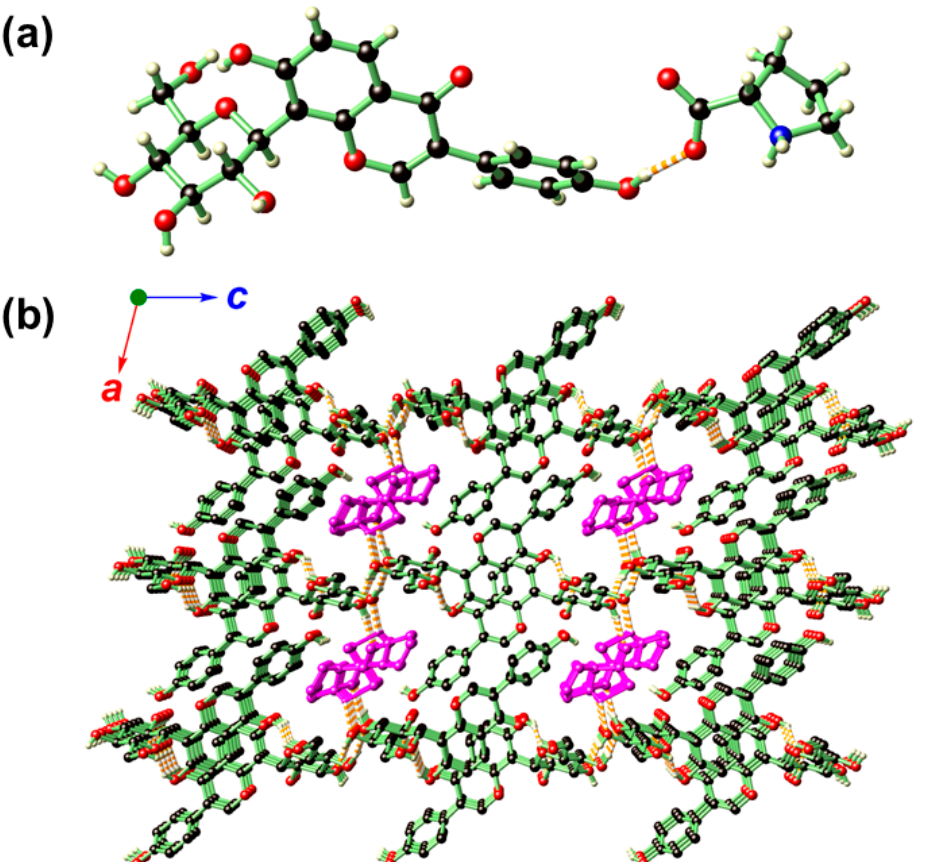
Figure 2. The asymmetric unit ( a ) and hydrogen-bonding network ( b ) of I . In b, the structure is propagated along the crystallographic a and c directions showing that PRO (distinguished by dark magenta for clarity purpose) resides inside the 1D channels generated by stacking of the PUE molecules. Color codes: O (red), N (blue), C (black), H (light yellow).